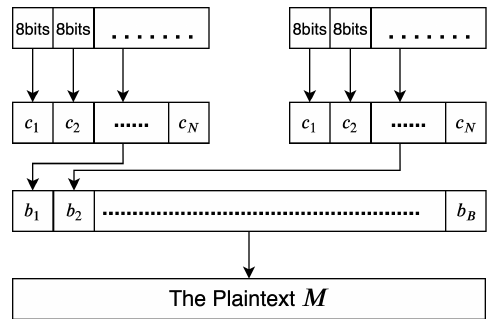
Figure 13. Converting binary values into plain text M